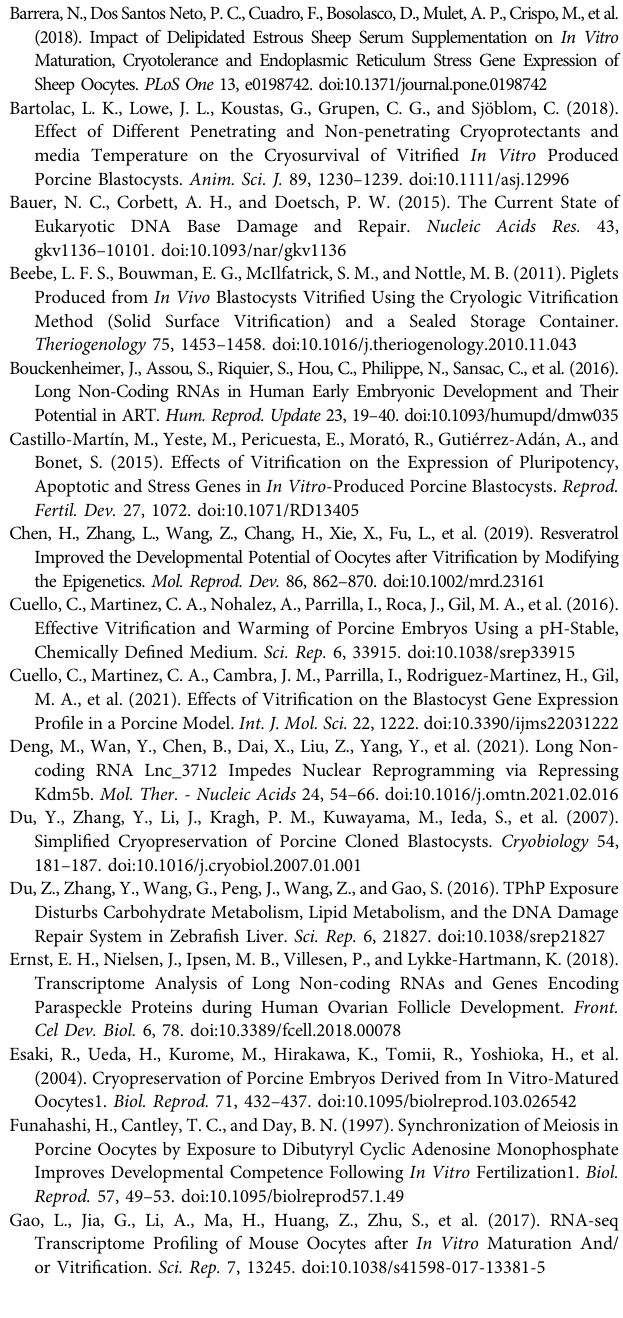
Supplementary Table S9 | LncRNA target prediction. Supplementary Table S10 | GO and KEGG enrichment analysis of mRNAs in 2- cells. Supplementary Table S11 | GO and KEGG enrichment analysis of lncRNAs in 2- cells.